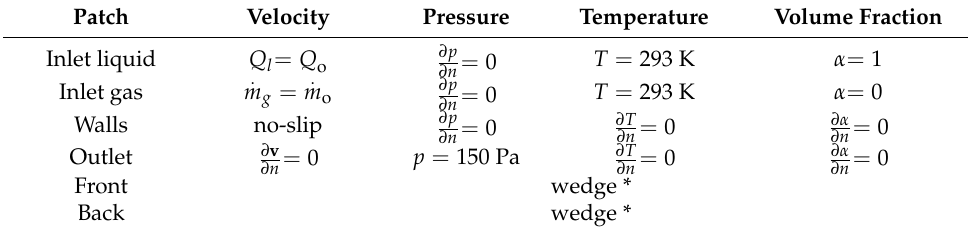
Table 1. An overview of boundary conditions at five